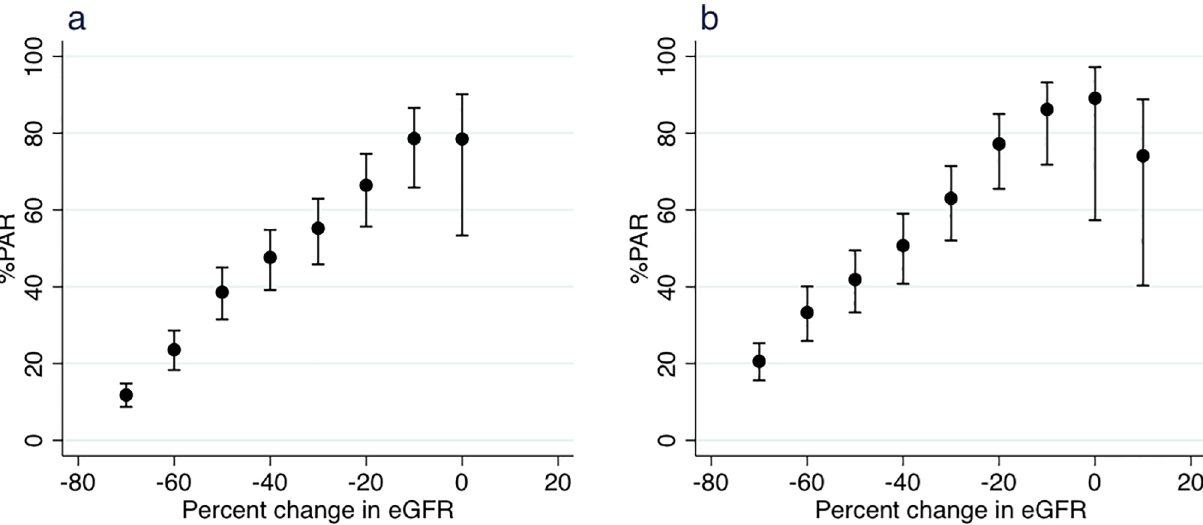
Fig 4. Percent population attributable risk (%PAR) of end-stage renal disease associated with percent changes in eGFR during the (a) 2-year or (b) 3-year baseline period.